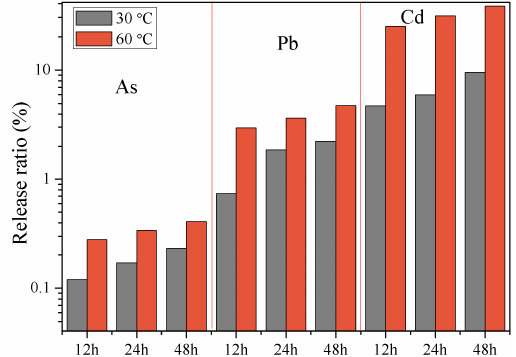
Figure 5. Release ratios of As, Pb and Cd at 30 and 60 ◦ C for times of 12, 24, and 48 h in the simulated environment of air.